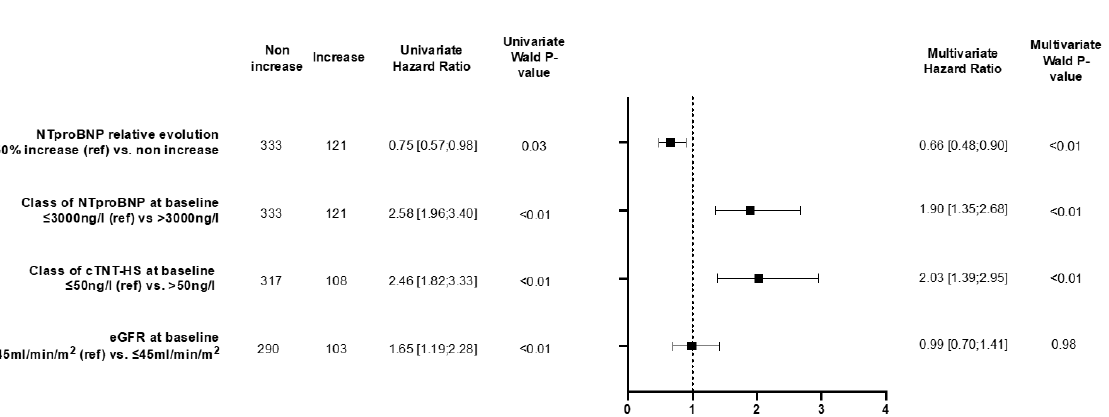
Table 2. Characteristics of patients treated with tafamidis (Cohort B) and with NT-proBNP assessments before and after initiating tafamidis ( n = 248).